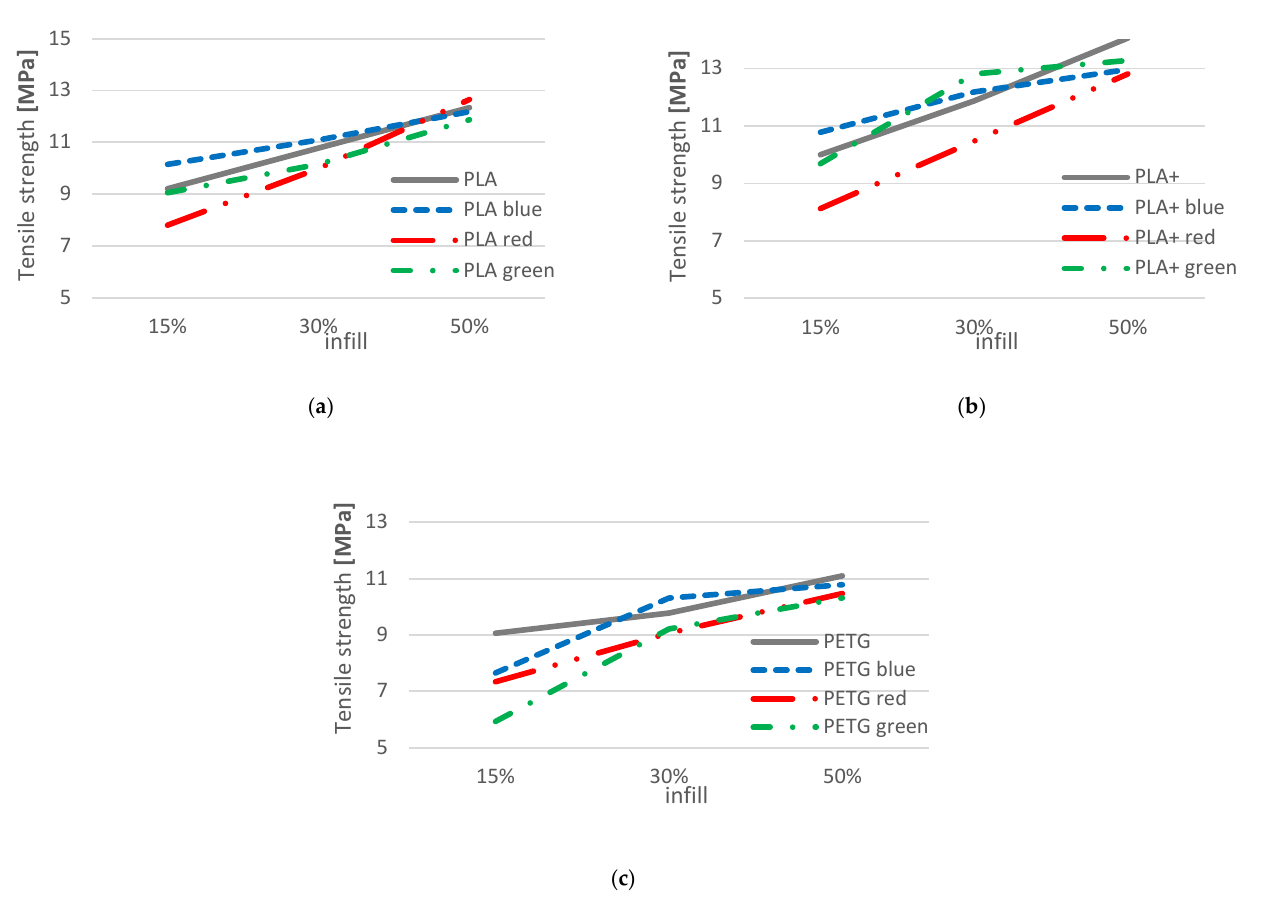
Figure 15. Comparison of tensile strength between coloured and uncoloured printed parts: ( a ) PLA material; ( b ) PLA+ material; ( c ) PETG material.